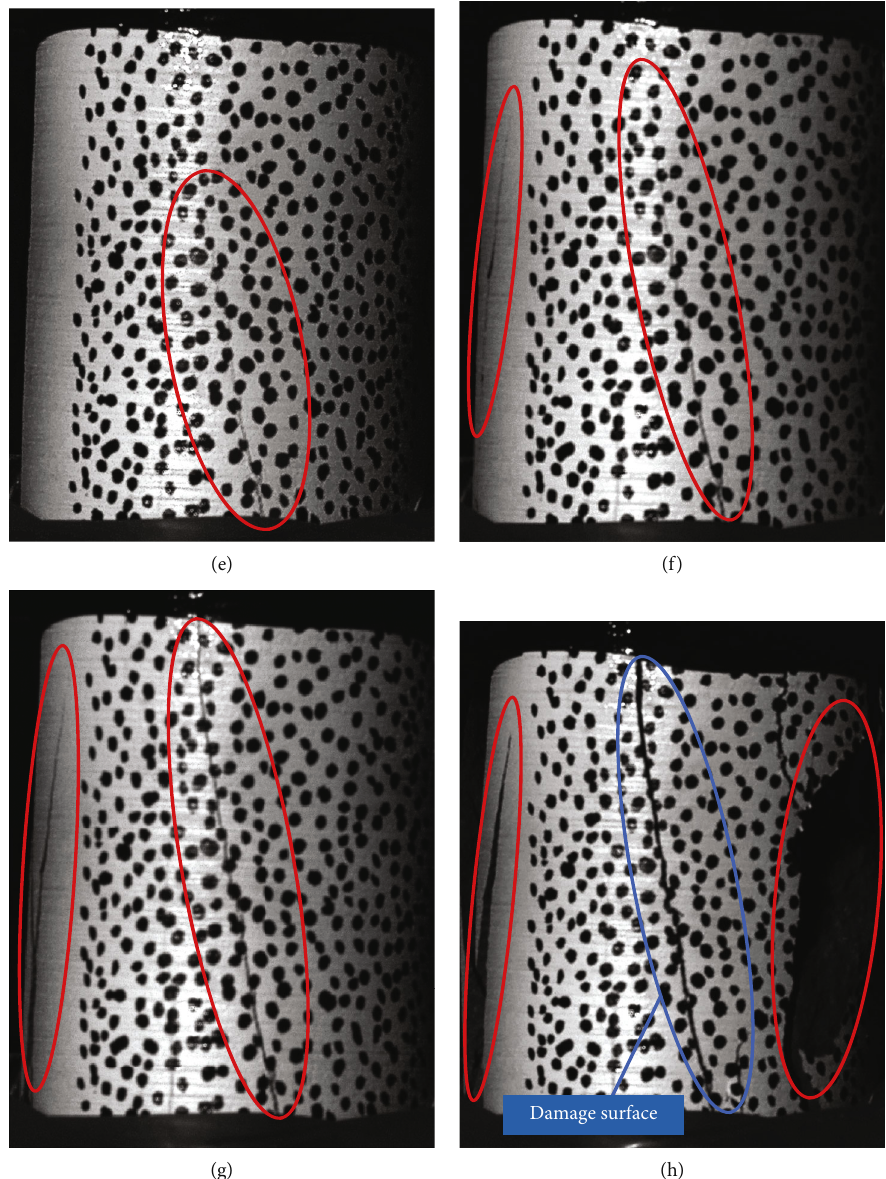
Figure 6: (a ~ d) AE source location and spatial evolution of rock sample U0-1 at di ff erent loading stages. (e ~ h) Physical images corresponding to the AE source location at di ff erent loading